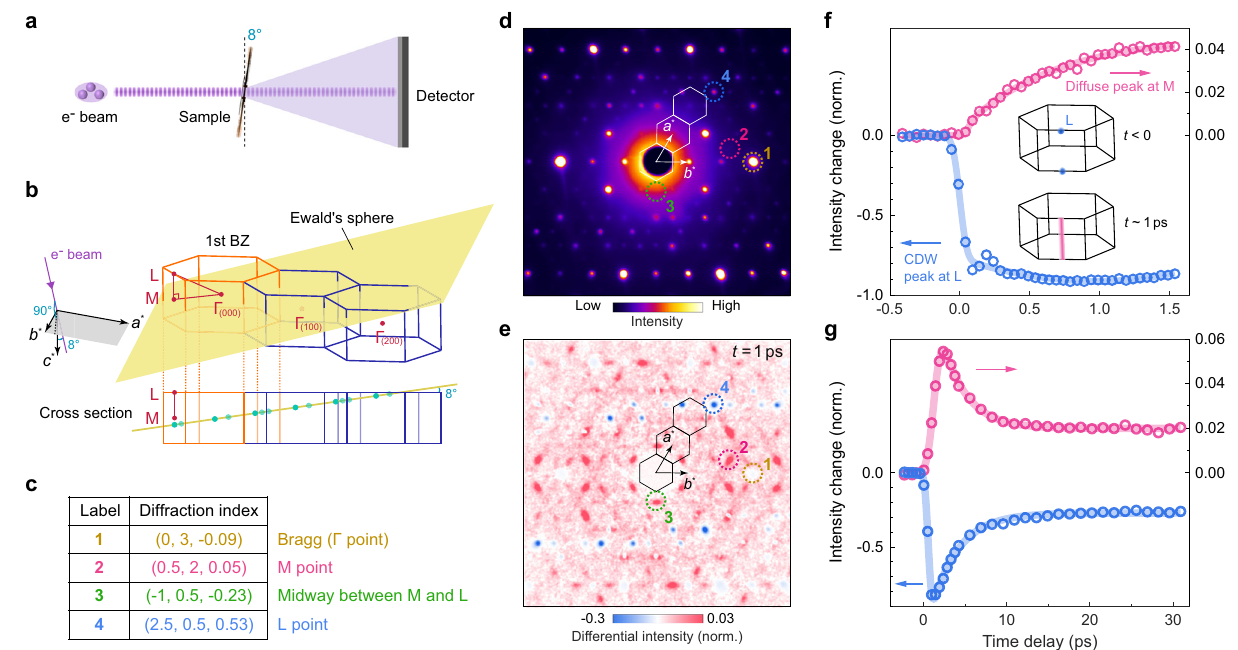
Fig. 2 Light-induced dimension crossover from a 3D to 2D CDW. a Schematic of electron diffraction geometry for data presented in panels ( d – g ), where an ultrathin sample cleaved in the (0 0 1) plane is rotated by 8 ∘ relative to the incident electron beam. b Illustration of the intersection between the reciprocal lattice and the Ewald ’ s sphere, which is locally approximated by a plane that corresponds to the diffraction pattern in ( d ) and ( e ). Green dots in the cross-sectional view mark the intersection points between the L – M – L line and the Ewald ’ s sphere. c Miller indices for four color-coded points in the diffraction images. d Static electron diffraction pattern taken at 88 K in the tilted geometry with zone axis equal to ð 365164 Þ . The three hexagons correspond to the projection of the three Brillouin zones in ( b ) onto the Ewald ’ s sphere. e Differential diffraction pattern at 1 ps after photoexcitation by an 800-nm, 30-fs pulse. f Time evolution of the CDW peak at the L point (peak 4, blue) and the diffuse peak at the M point (peak 2, red). Intensity values are normalized by their respective averages before photoexcitation. See Supplementary Fig. 5b for traces of additional peaks. Inset illustrates the photoinduced change in the CDW dimensionality, sketched in the reciprocal space. g The same as ( f ) but plotted for extended pump-probe time delay, showing the partial recovery to a quasi-equilibrium plateau. In f and g , error bars of intensity change are smaller than the marker size; solid curves are fi ts to an error function multiplied by an exponential function. The incident fl uence for data presented in ( e – g ) is 560 μ J/cm 2